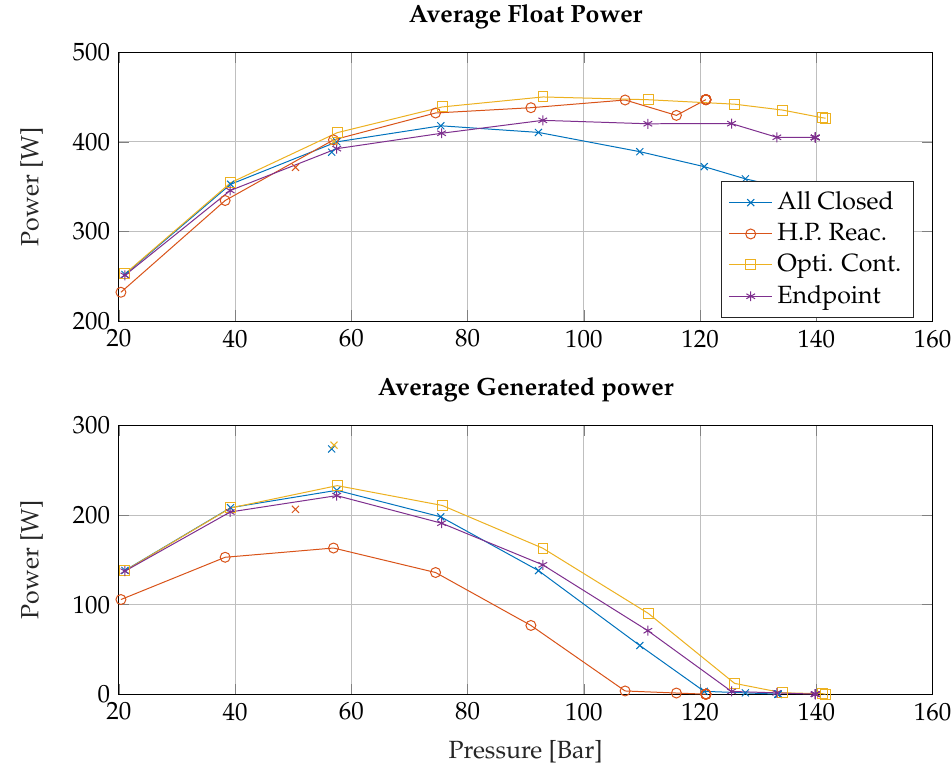
Figure 12. Average power over different system pressures with x-marked optimal motor torque control algorithm. Wave input: Irregular